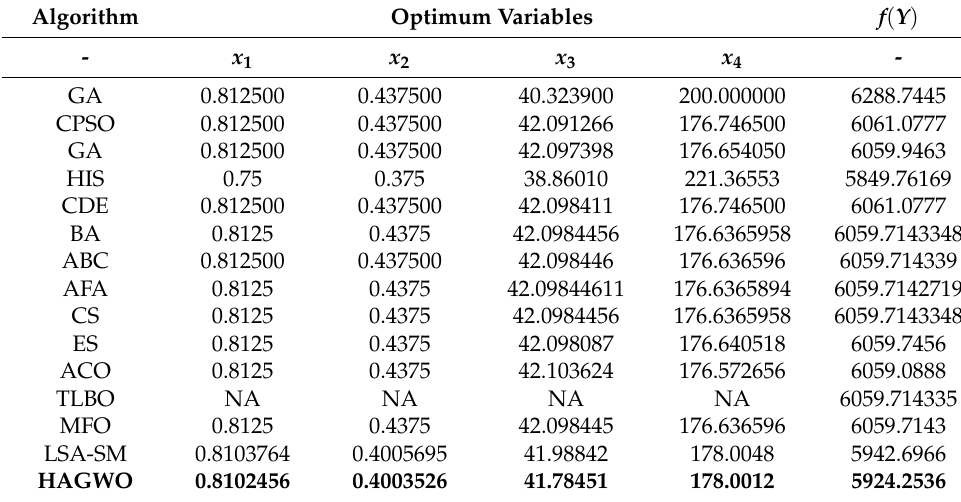
Table 12. Best optimal solutions of the welded beam design by